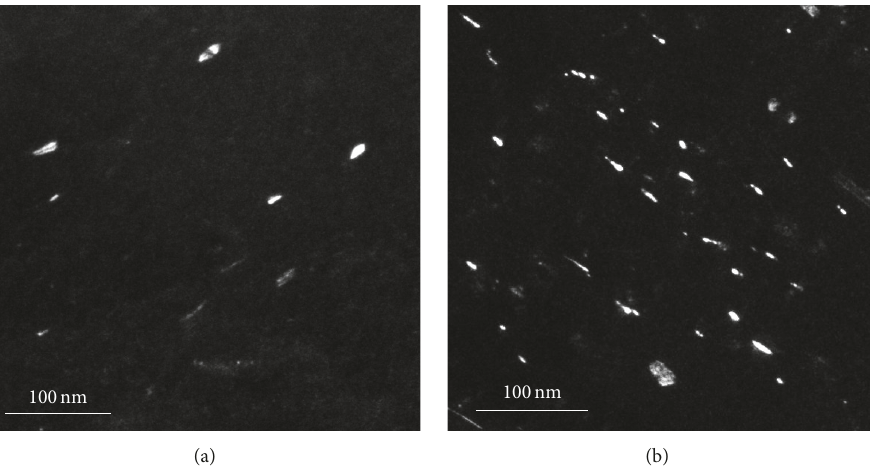
Figure 10: Dark field images of carbonitrides in 15Kh2NMFAA steel: (a) as-received specimen and (b) after irradiation at 400 ∘ C.